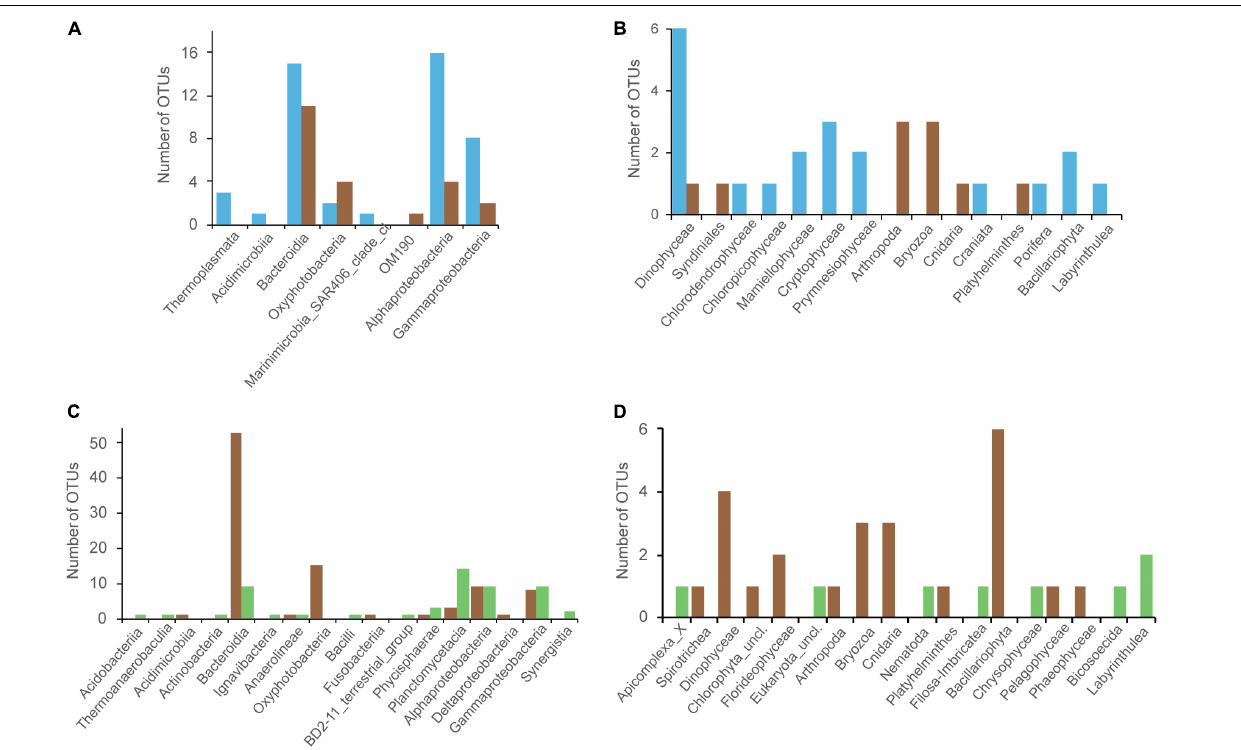
FIGURE 5 | Identification of the OTUs presenting significant differential abundance for the different Sargassum -associated samples, via the ANOVA-like differential expression (ALDEx2) analysis. Comparison between tide sites OTUs that are differentially represented between seawater (TS-sw, blue ) or Sargassum